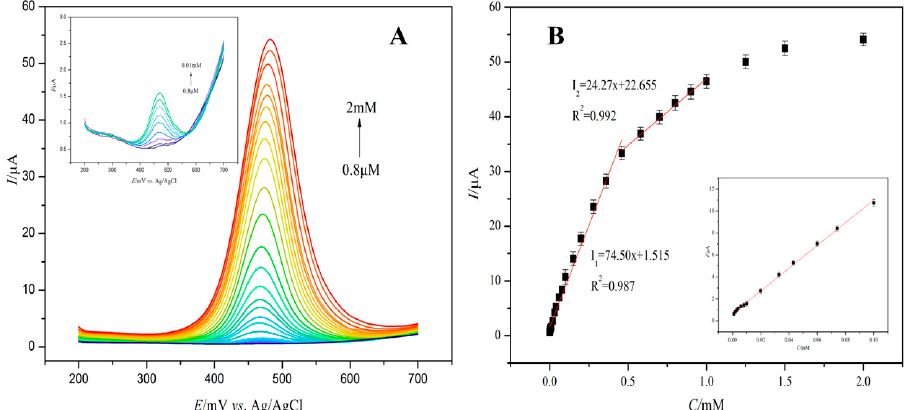
Figure 6. ( A ) DPVs of the Zn-PPIX-CS-MWCNT-modified GC electrode with different concentrations of caffeic acid from 0.8 µ M to 2 mM; ( B ) calibration curve of the electrocatalytic oxidation-peak current as a function of caffeic-acid concentration. Table 1. Comparison of electrochemistry biosensors modified by different nanomaterials for the detection of caffeic acid.